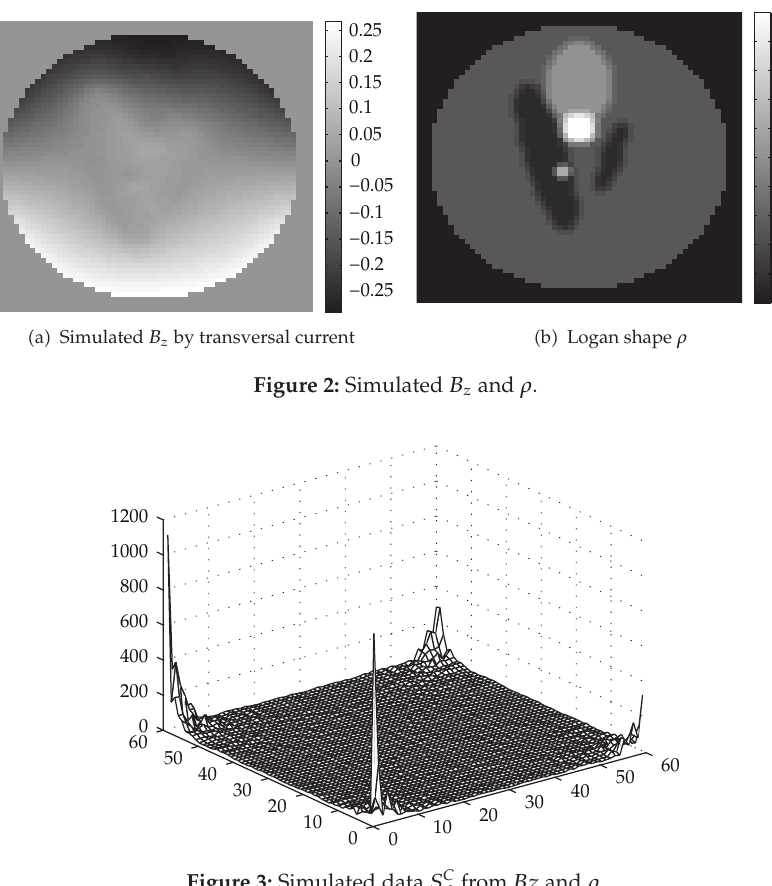
Figure 3: Simulated data S C d from Bz and ρ